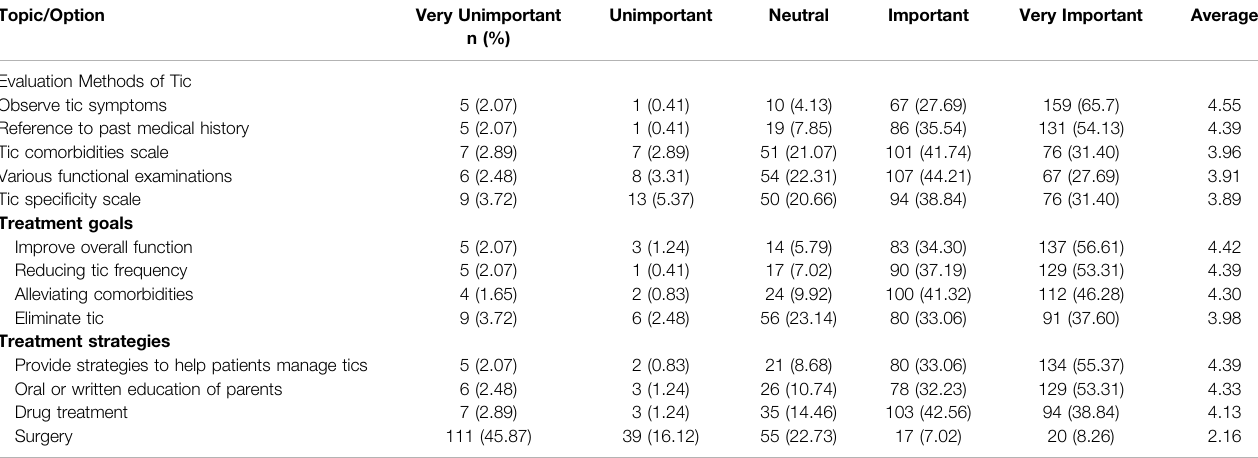
TABLE 2 | Evaluation methods, treatment goals, and treatment strategies of tic (N = 242).